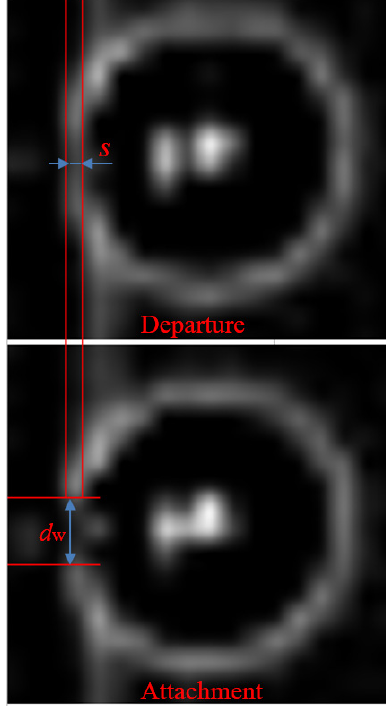
Figure 7. Determination of bubble separation.